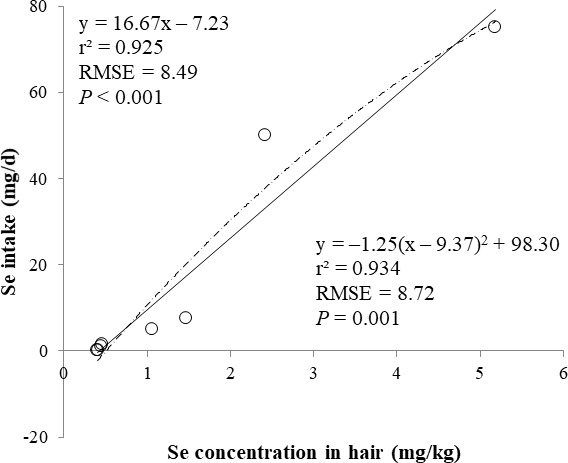
Linear and quadratic regression equations for estimating daily selenium (Se) intake (mg/d) based on the Se concentration in hair (mg/kg) on d 15 and 30.Each data point represents least squares mean of four observations. r2, coefficient of determination; RMSE, root mean square of error.